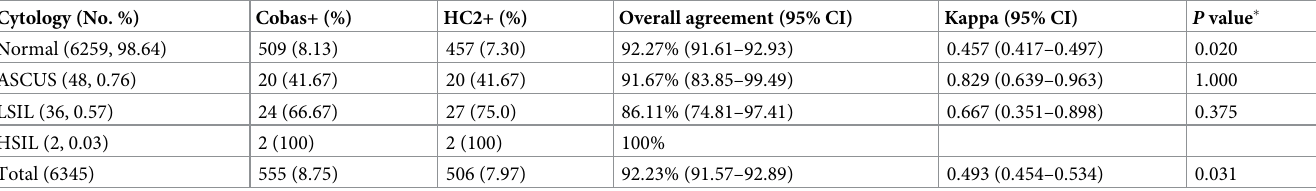
Table 1. HPV prevalence and concordance analysis of Cobas and HC2 tests stratified by cytology. Cytology (No. %)